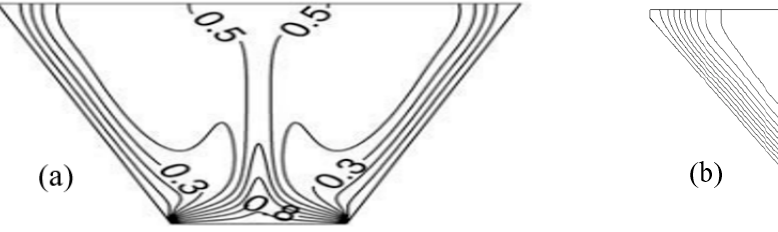
Figure 3. Comparison of the results of Basak et al. [26]: ( a ) the present study; ( b ) for the temperature contours in the trapezoidal enclosure where Ra = 10 5 , Pr = 0.7, and inclination angle ϕ = 45 ◦